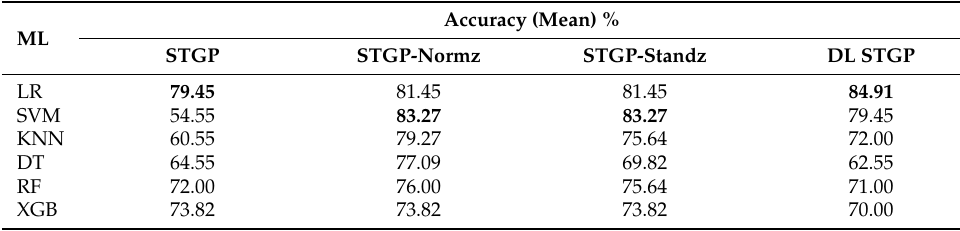
Table 7. HOA vs. HC Accuracy of ML models.